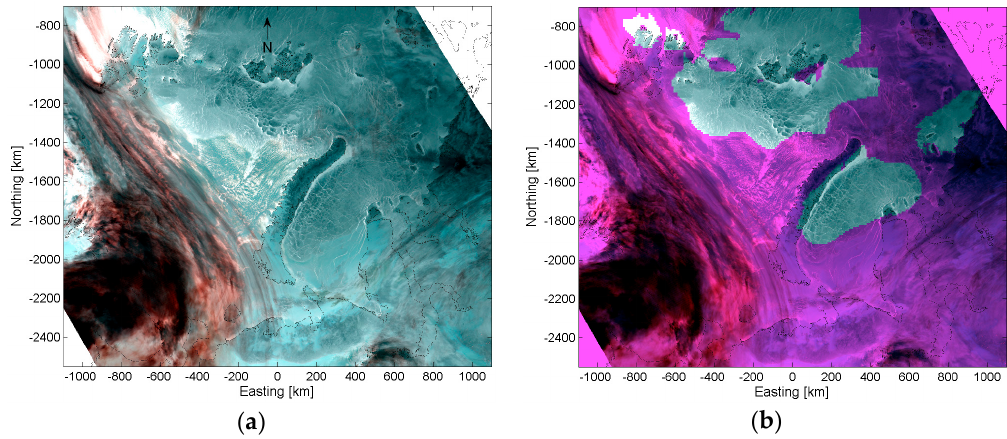
Figure 2. An example of the MODIS night-time data cloud mask processed using automatic cloud detection tests and manual methods. The Terra MODIS data was acquired on 26 January 2015, 16:50 UTC. ( a ) MODIS RGB-image from bands 20, 31 and 32; ( b ) cloud mask in the same RGB-image. The pixel size of the RGB-images is 1 km, and the cloud mask has 10 km by10 km block size.